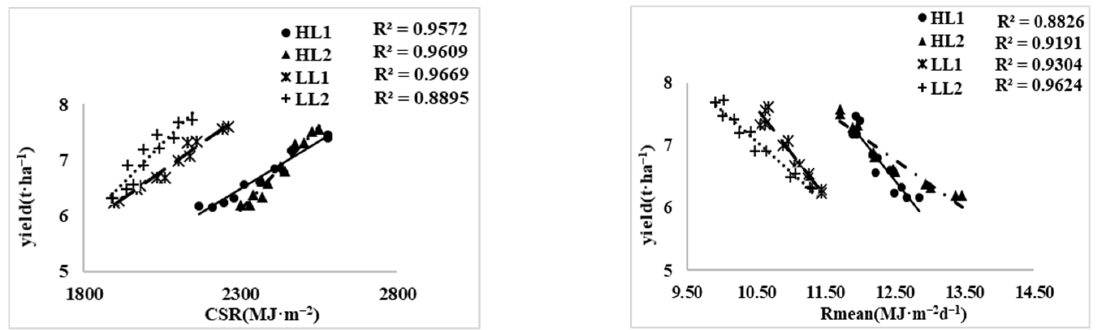
Figure 2. Correlation between radiation and yield during the whole growth period. HL1: 2017–2018